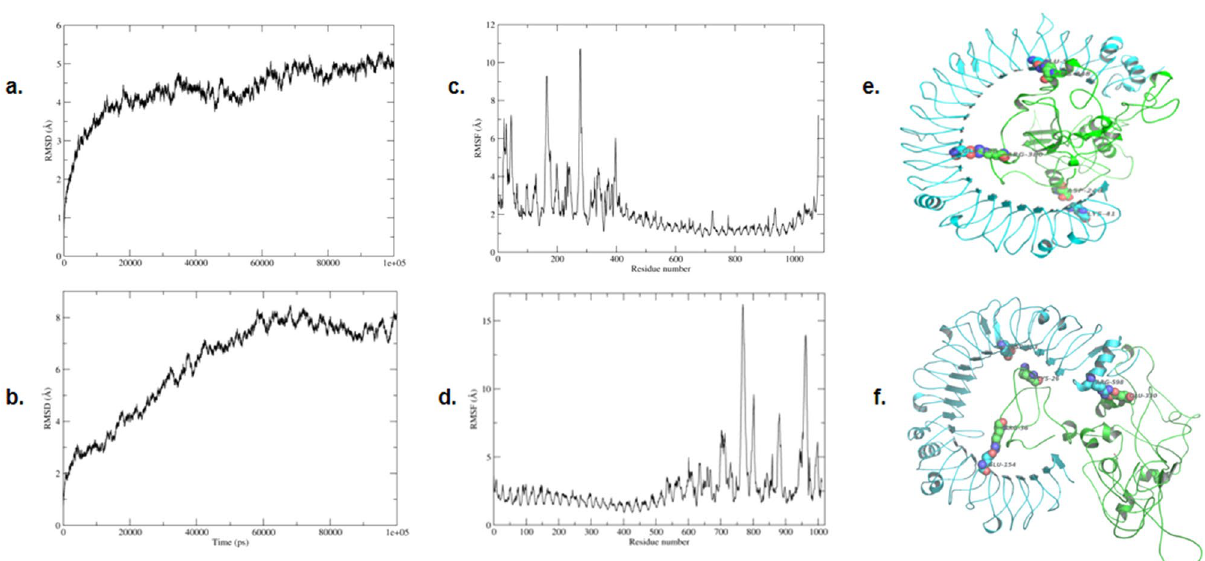
Figure 5. MD Simulation Results. ( a ). RMSD curve for TLR3-chimeric vaccine construct complex, ( b ). RMSD curve for TLR4-chimeric vaccine construct complex, ( c ). RMSF curve for TLR3-chimeric vaccine construct complex, ( d ). RMSF curve for TLR4-chimeric vaccine construct complex. The beta sheets of the TLR3 and TLR4 show limited flexibility. The flexibility of the interface binding residues is also less indicating stable interactions, ( e ). The complex of TLR3-chimeric vaccine construct complex generated by the VMD software version 1.93 57 , ( f ). The complex of TLR4-chimeric vaccine construct complex generated by the VMD software version 1.93 57 , Three most stable salt bridges are shown for both of the complexes. The salt bridges anchor the two proteins by stable salt-bridge interactions. The complex of TLR3-chimeric vaccine construct showed stronger salt-bridge interactions as measured by occupancy indicating it may be comparatively more stable than TLR4-chimeric vaccine construct